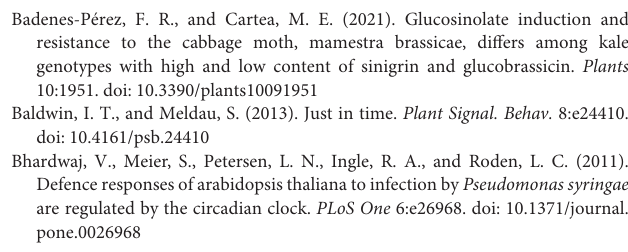
Supplementary Figure 1 | (A) Multivariate analysis using supervised partial least squares discriminate analysis (PLS-DA) in separation of control and wounded leaves from broccoli leaves harvested at ZT0. (B) Cross validation analysis indicated that two components model was the optimal model for broccoli samples. (C) PLS-DA analysis of control and wounded leaves from turnip greens harvested at ZT8. (D) Cross validation analysis indicated no discrimination between turnip greens samples. Colored circles represent 95% confidence intervals. Colored dots represent individual samples. The component that best classifies the model is shown with red asterisk. Supplementary Figure 2 | Volcano plot displaying features that were most differentially expressed at wounded broccoli plants relative to control at ZT0. Supplementary Table 1 | Metabolomic dataset of features detected in broccoli leaves using UPLC-Q-TOF-MS/MS. Supplementary Table 2 | Metabolomic dataset of features detected in turnip greens leaves using UPLC-Q-TOF-MS/MS. Supplementary Table 3 | Metabolomic dataset of important features (based on VIP-score values of the PLS-DA analysis and on the volcano-plot analysis) contributing to the responses of wounding and M. brassicae feeding behavior from broccoli samples at